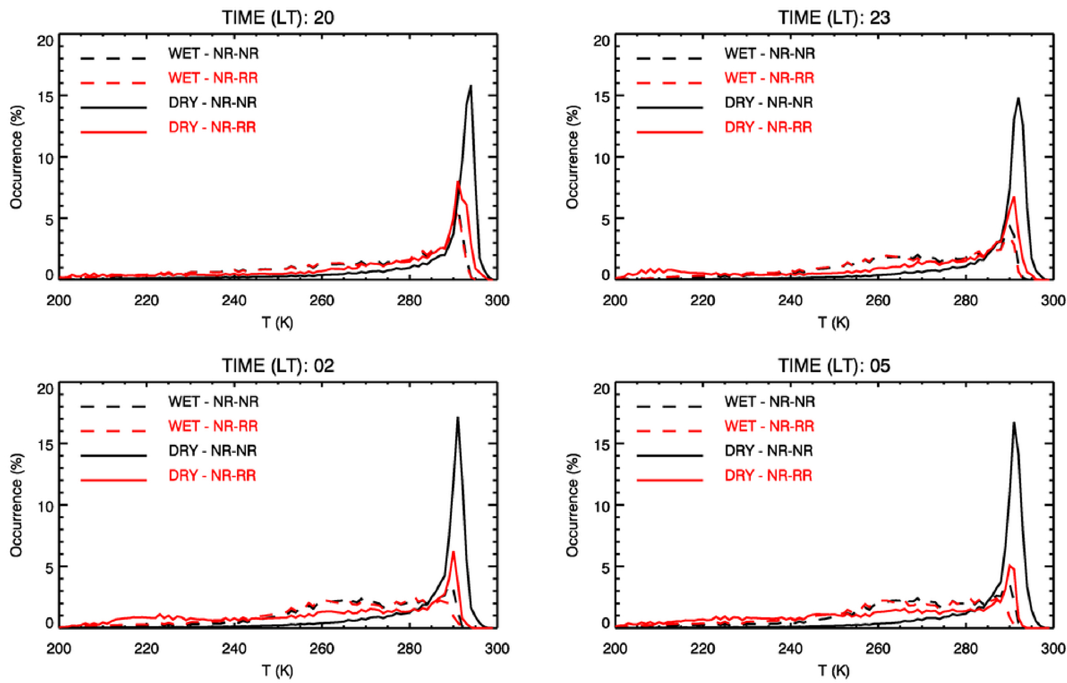
Figure 14. Probability distributions (grouped in 3h groups) of GOES 10.4µm brightness temperatures for dry and wet seasons and NR–NR and NR–RR transitions during the nighttime period. The time at each panel is the start time (LT).